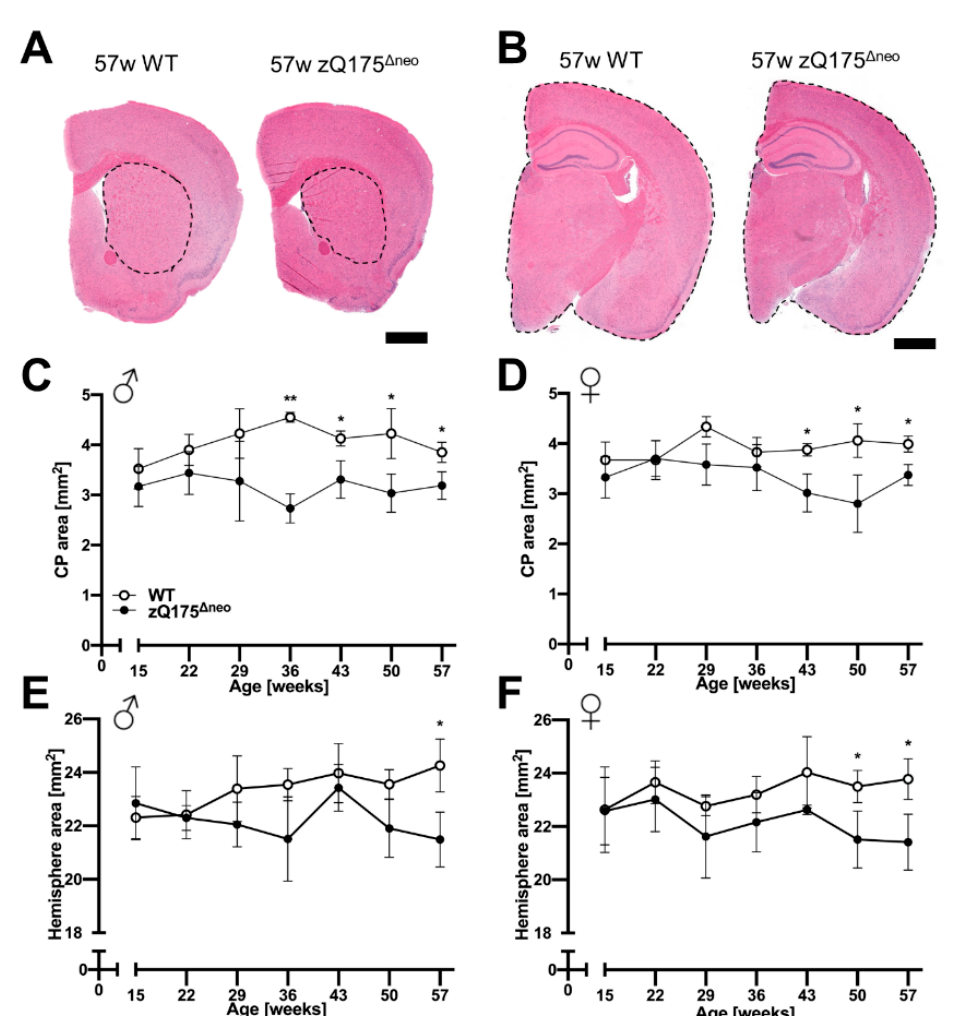
Figure 7. Caudate-putamen (CP) and total hemispheric atrophy were observed in adult zQ175 Δ neo mice compared to WT littermates. ( A , B ) Representative images of H&E-stained coronal brain sections from 57-week-old female WT and zQ175 Δ neo mice at ( A ) +0.8 mm and ( B ) − 1.80 mm distance from bregma. Dashed lines indicate the measured area of ( A ) CP and ( B ) total hemisphere. The scale bars indicate 1000 µm. ( C – F ) Male ( C , E ) and female ( D , F ) zQ175 Δ neo mice ( ● ) show a reduction of the CP area ( C , D ) and the total hemisphere ( E , F ) compared to WT littermates ( ○ ). Data are presented as mean ± SD; N = 2–6. Significance was calculated using unpaired t -test followed by Holm-Šídák correction and is given as *: p ≤ 0.05, and **: p ≤ 0.01.